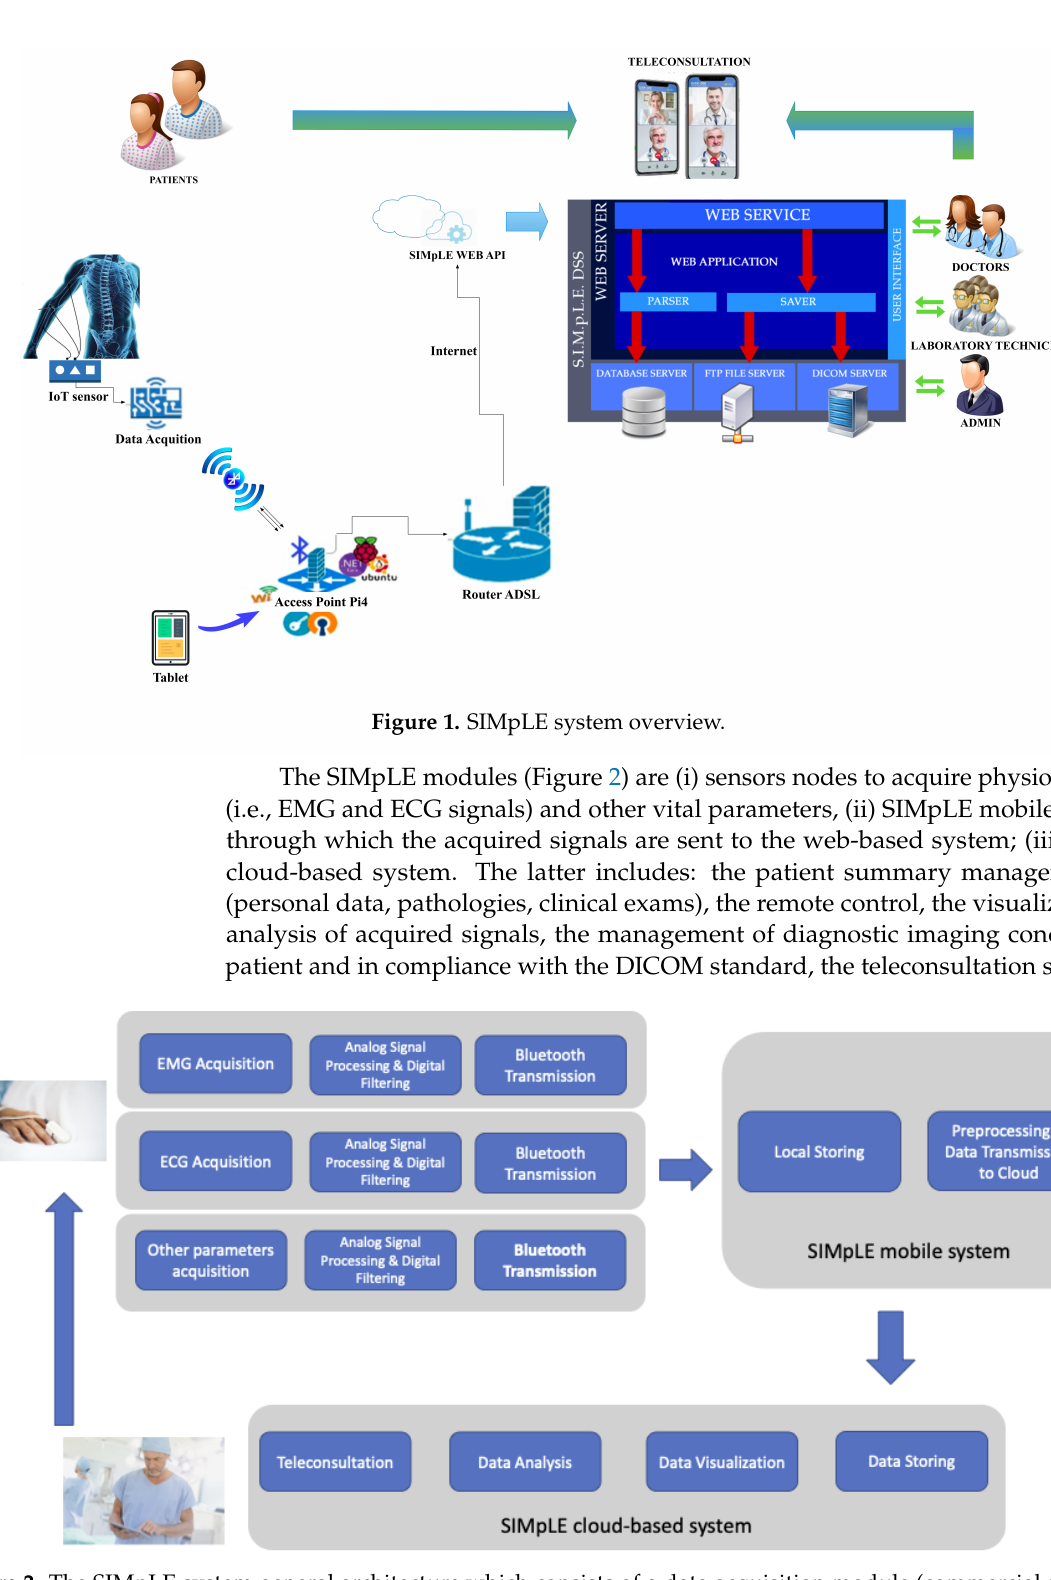
Figure 2. The SIMpLE system general architecture which consists of a data acquisition module (commercial sensors), a mobile system and a cloud-based